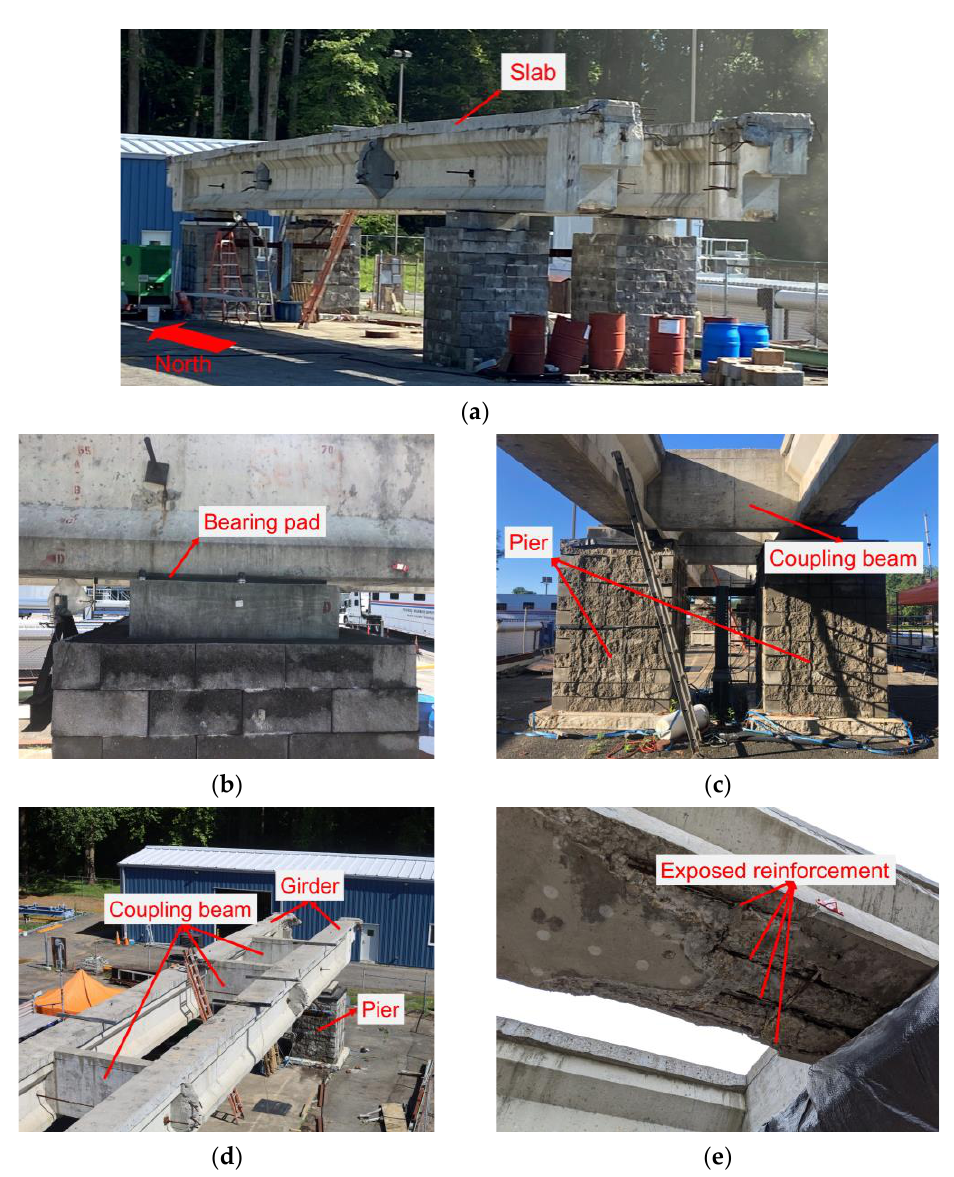
Figure 2. Testbed structure: ( a ) side view and north direction, ( b ) bearing pad, ( c ) piers and coupling beam, ( d ) top view, and ( e ) example of existing damage (west girder close to the north pier).